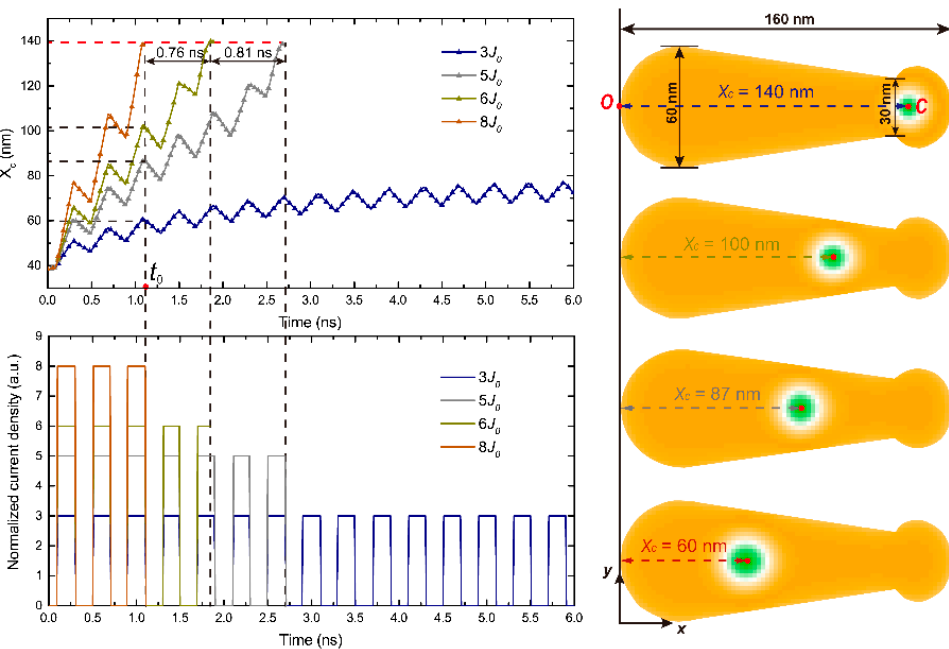
Figure 6. Micromagnetic simulations of the proposed skyrmion-based SNN under different ampli- tudes of I drive .